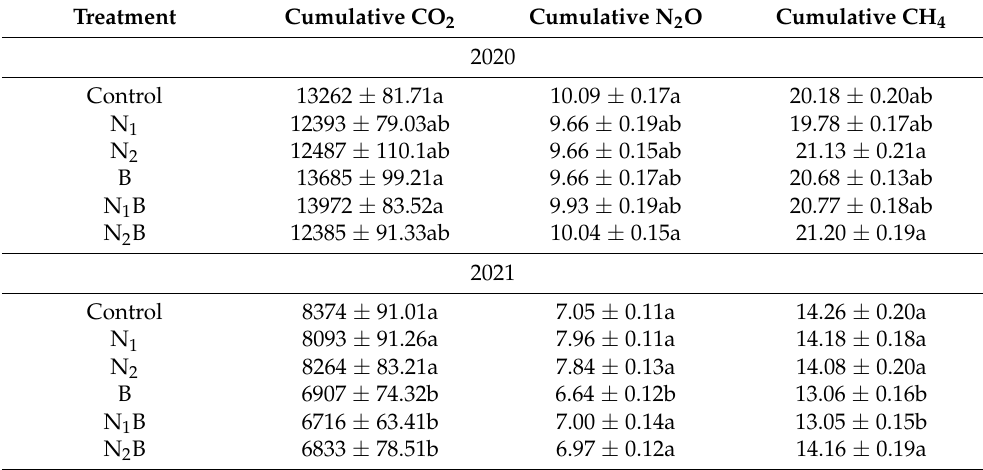
Table 2. Cumulative CO 2 –C, N 2 O–N, and CH 4 (mg ha − 1 hr − 1 ) emissions under different treatments over the two-year